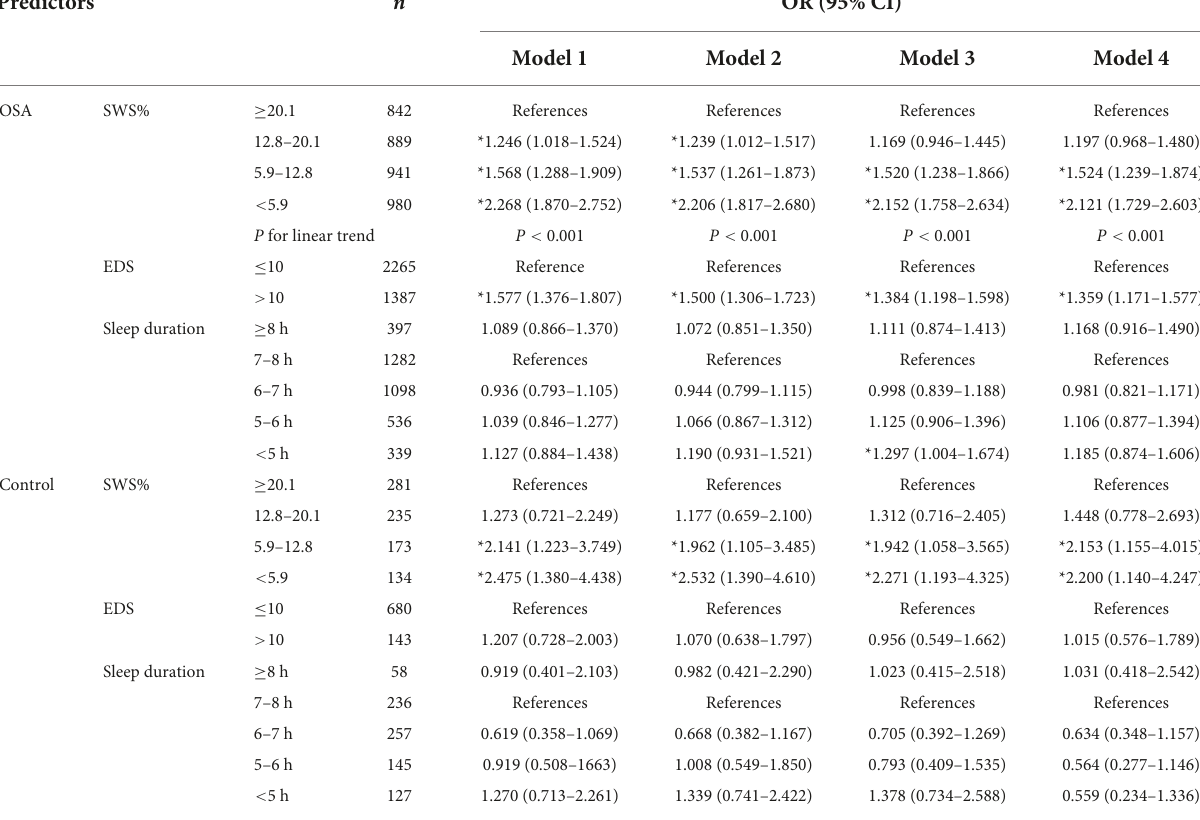
TABLE 4 Association of SWS, EDS, SSD and moderate-to-high Framingham CVD risk in stratified